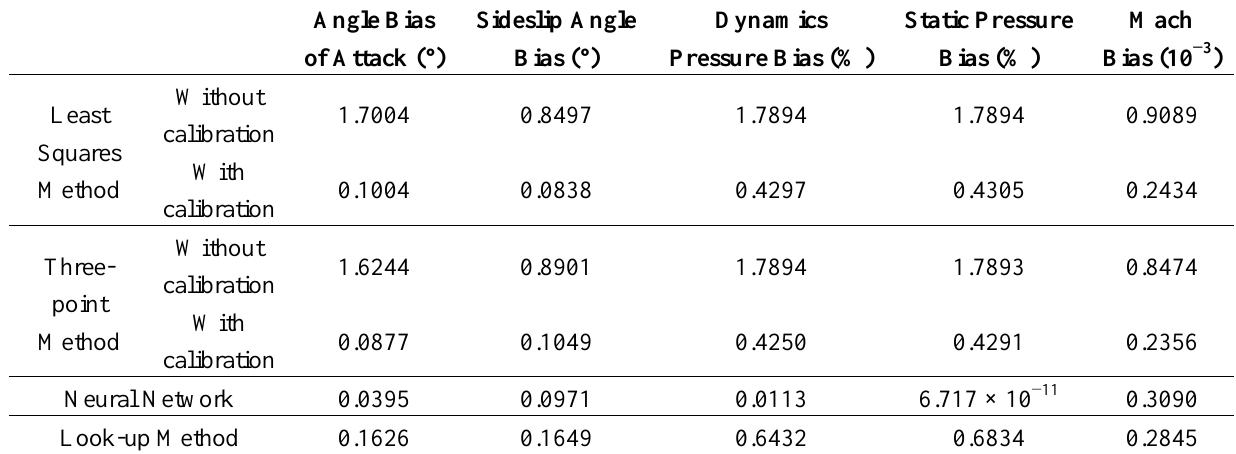
Table 1. Comparative results of different solving methods.